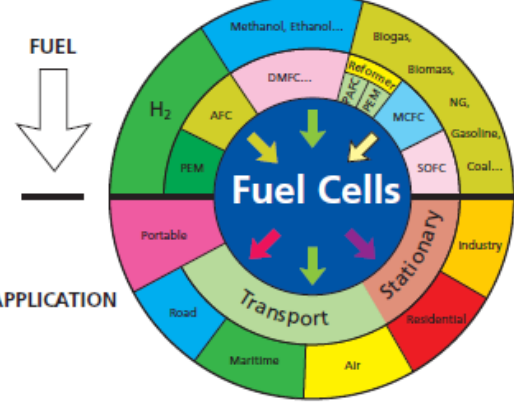
Figure 14. Types and applications of fuel cells [1].